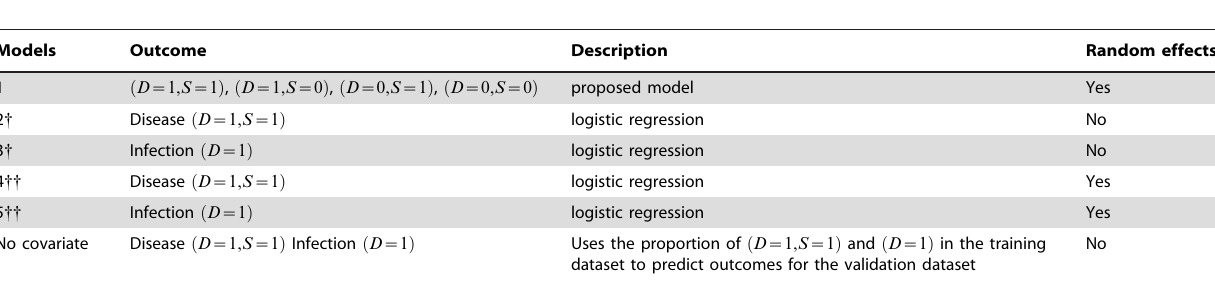
Table 2. Description of all the modeling approaches employed in the simulation and validation exercises.